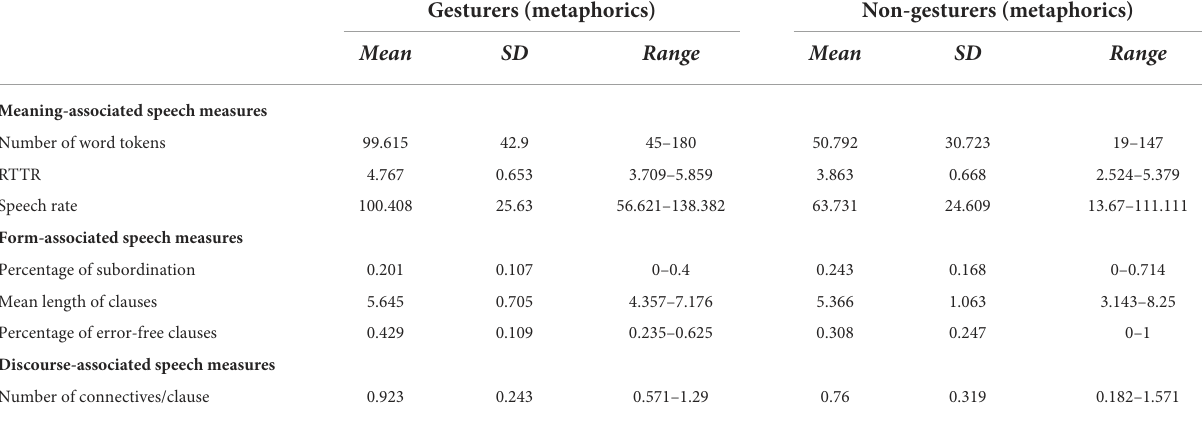
TABLE 6 Descriptive statistics of speech measures for gesturers and non-gesturers of metaphorics.